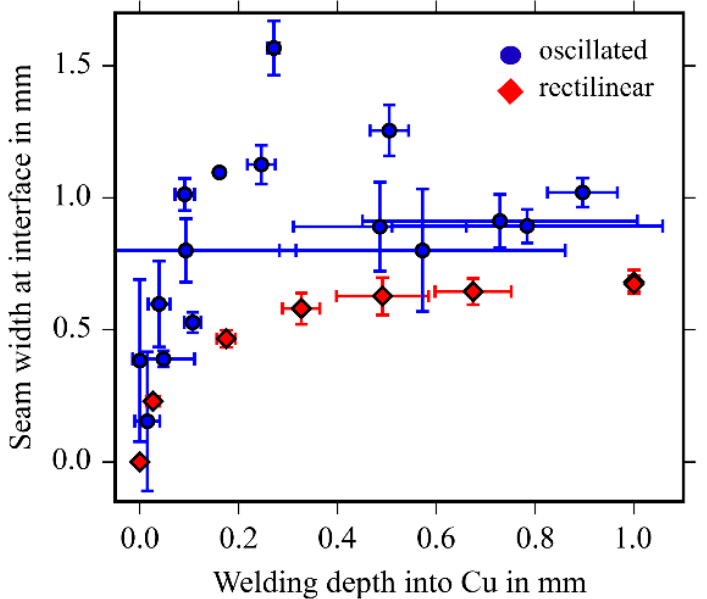
Figure 11. Seam width at interface over welding depth into Cu for welds produced with spatial beam oscillation (blue) and welding processes without beam oscillation (red). The error bars indicate the standard deviation.